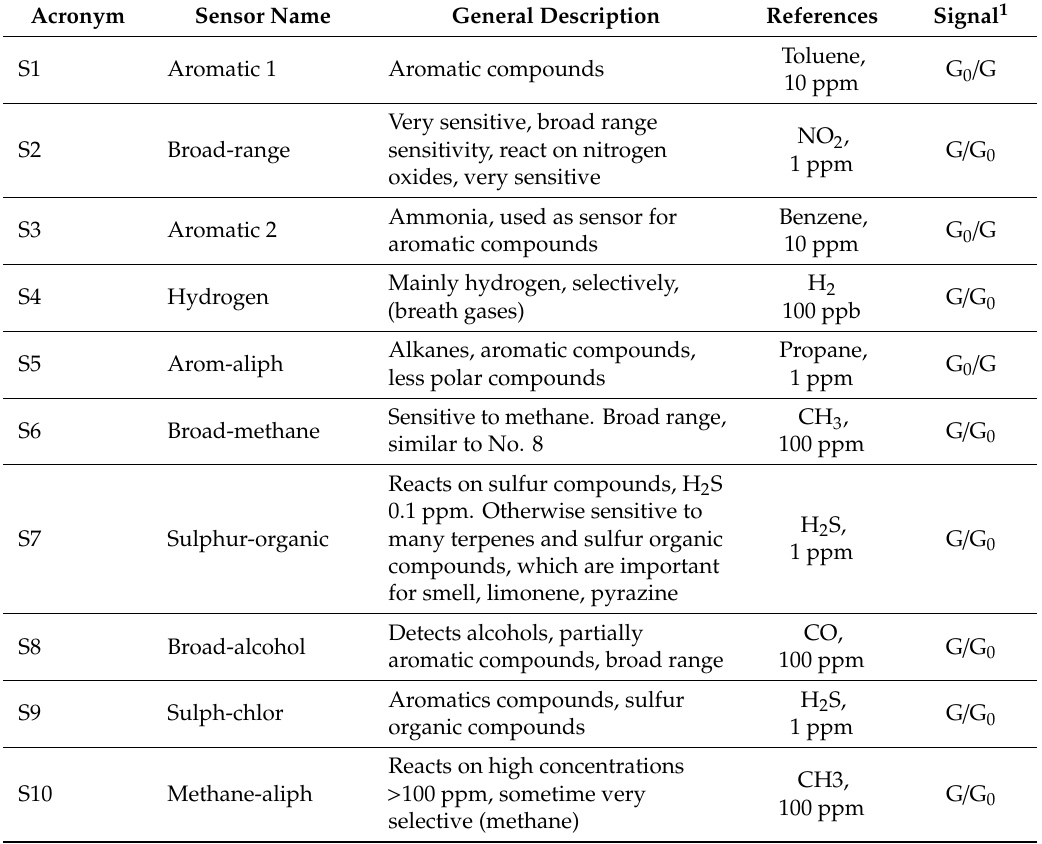
Table 1. Sensor acronym used in the test and related features as reported by the